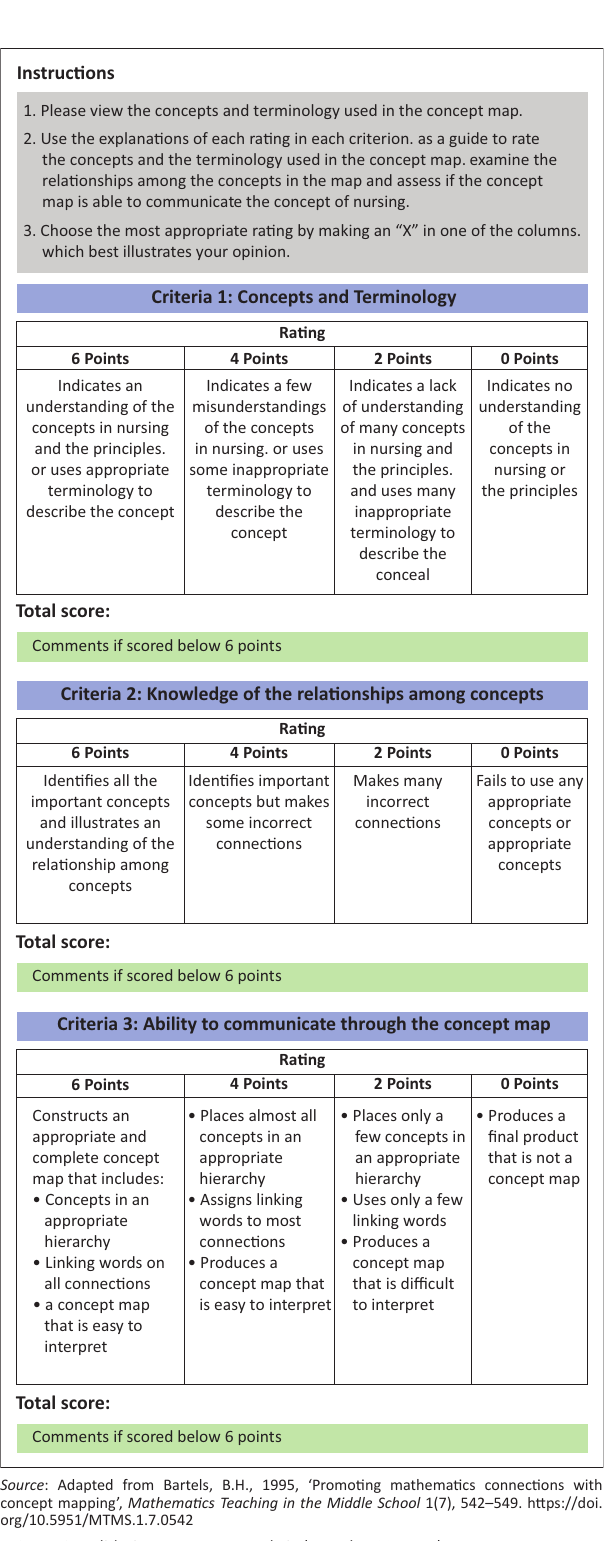
FIGURE 2: Validation assessment rubric (Bartels 1995:545).